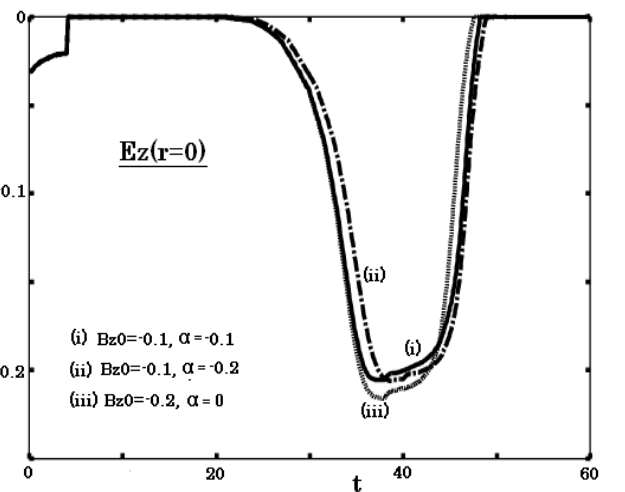
Fig. 2. Temporal variations in the electric field E z ( r = 0) at the origin for different values of B z 0 and α . Figure 2: Temporal variations in the electric fleld E at the origin for difierent values of B z 0 and fi .